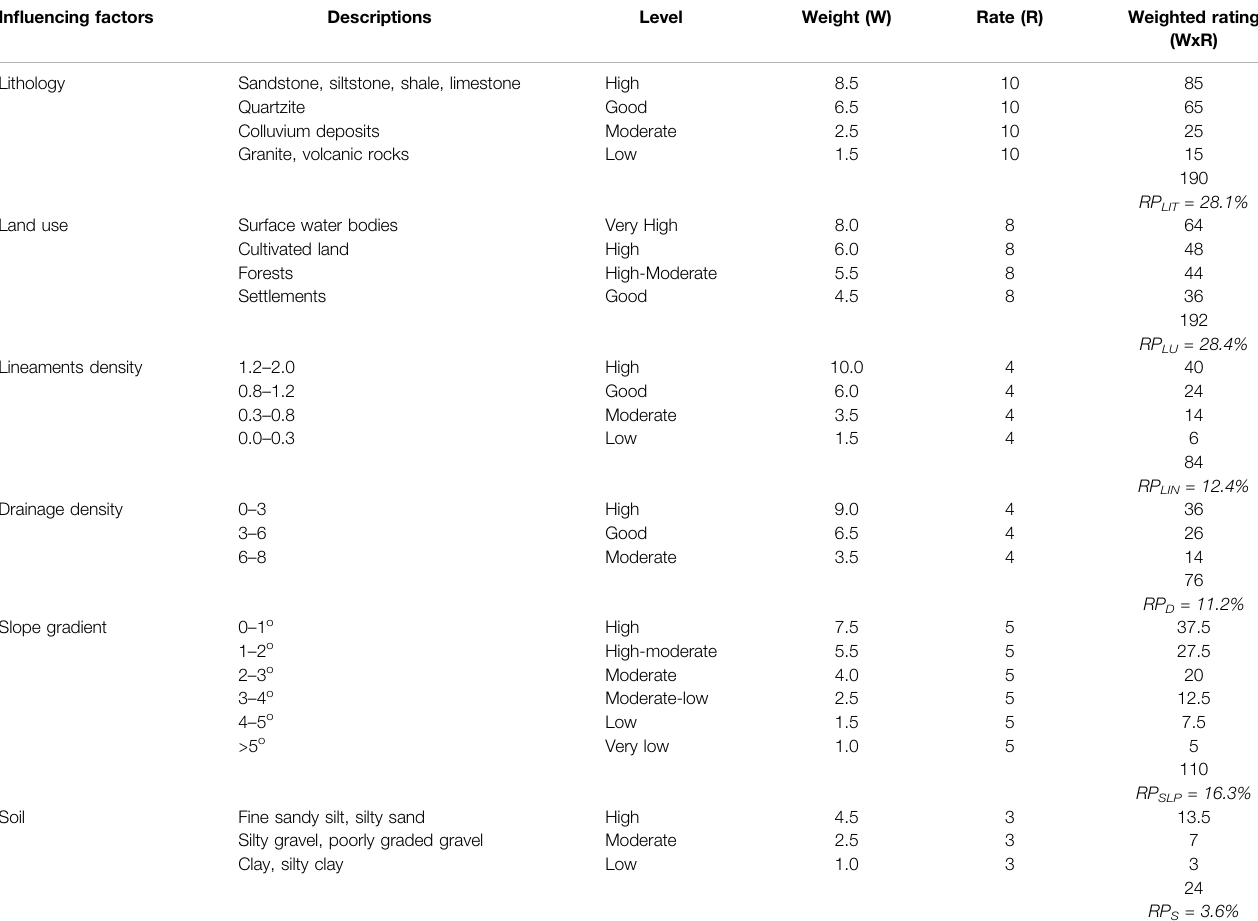
TABLE 4 | Weights and rates of the recharge potential in fl uencing factors (modi fi ed from Selvam et al., 2016). In fl uencing